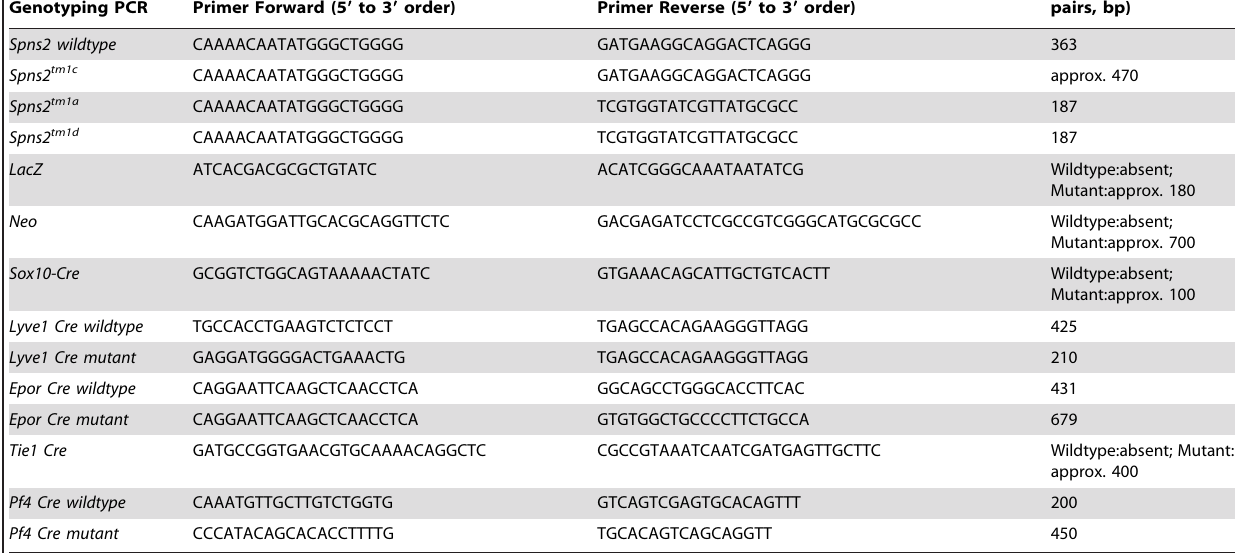
Table 1. Primers for